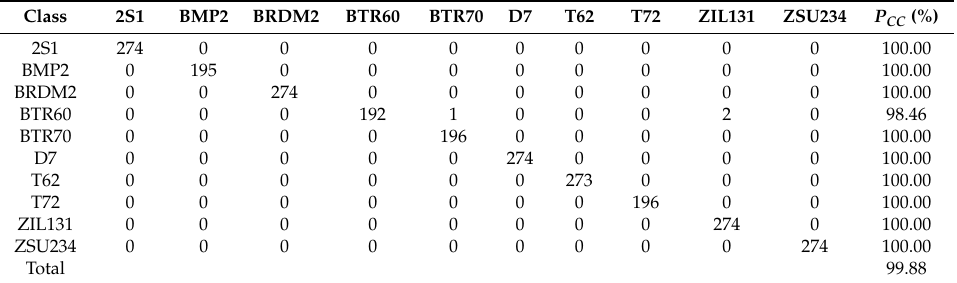
Table 3. Confusion matrix of a three-view MS-CNN under SOC.